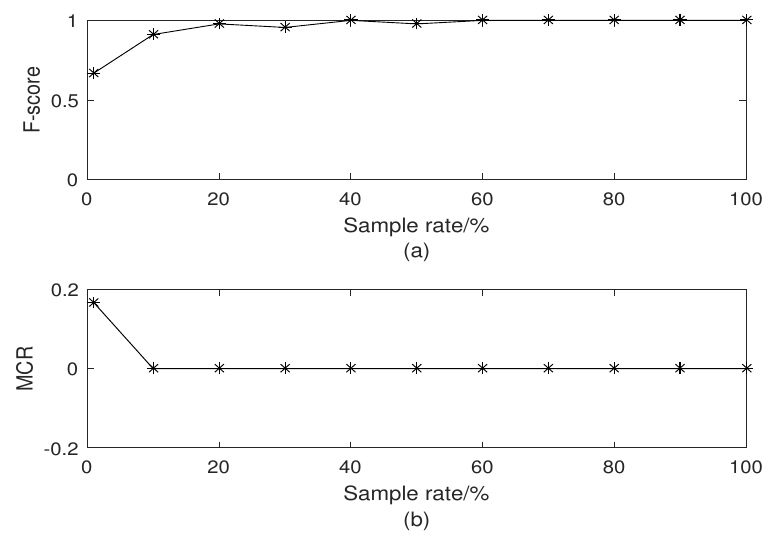
Figure 4. Clustering performance versus sampling rate. ( a ) F-score versus sampling rate; ( b ) MCR versus sampling